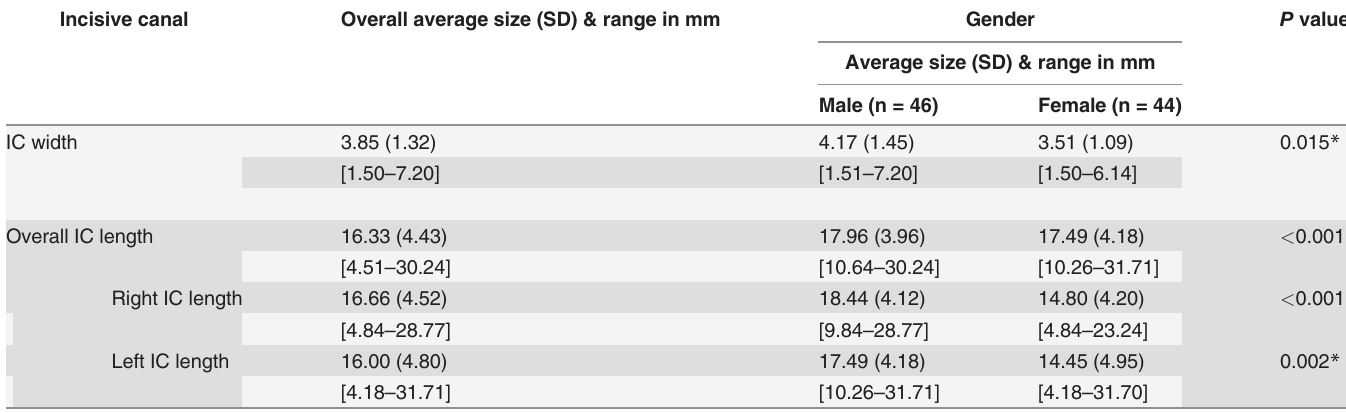
Table 2. The mean dimensional measurement of the maxillary incisive canal. Incisive canal